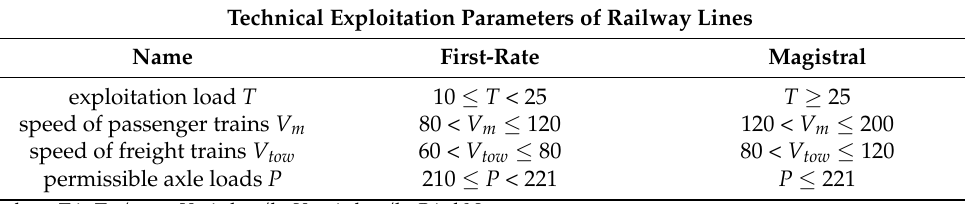
Table 1. Technical exploitation specifications of the complete